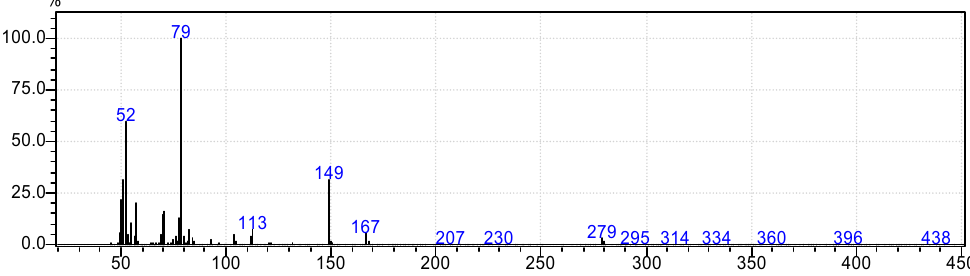
Figure 10. Mass spectrum of the date juice sample at a retention time of 5.33 min. ( A ) Standard sucrose; ( B ) Date juice.